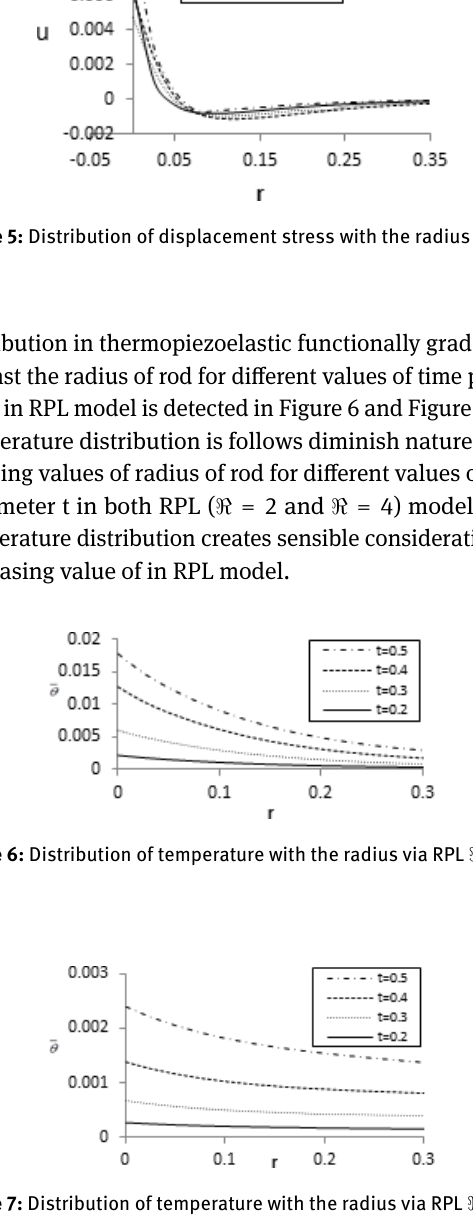
The distribution of electric displacement in ther- mopiezoelastic functionally graded rod against the radius of rod for different values of concentration constants in RPL model is noticed in Figures 8 and 9. The distribution of electric displacement follows oscillating nature for increas- ing values of radius for different concentration constants. The distribution of electric displacement creates reason- able attention for increasing value of ℜ in RPL model. The frequency in thermopiezoelastic functionally graded